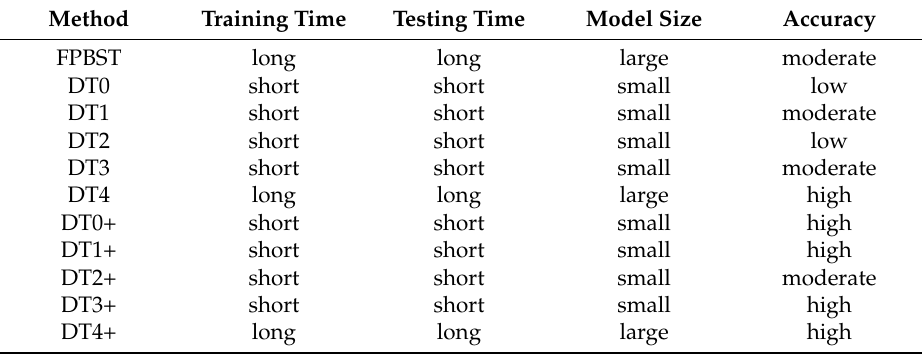
Table 12. Approximate comparison of the performance of the proposed methods to that of the FPBST.